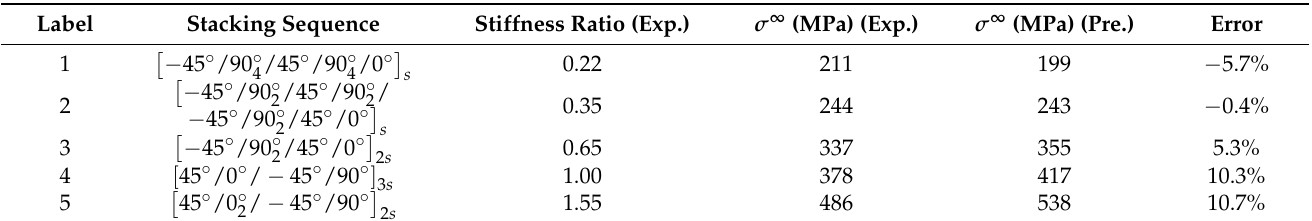
Table 2. The notched tensile strength of symmetrical balanced laminates with material of Hexcel F593 epoxy